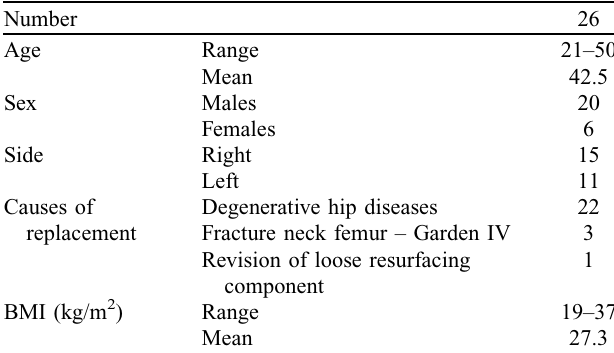
Table 1. Patient’s